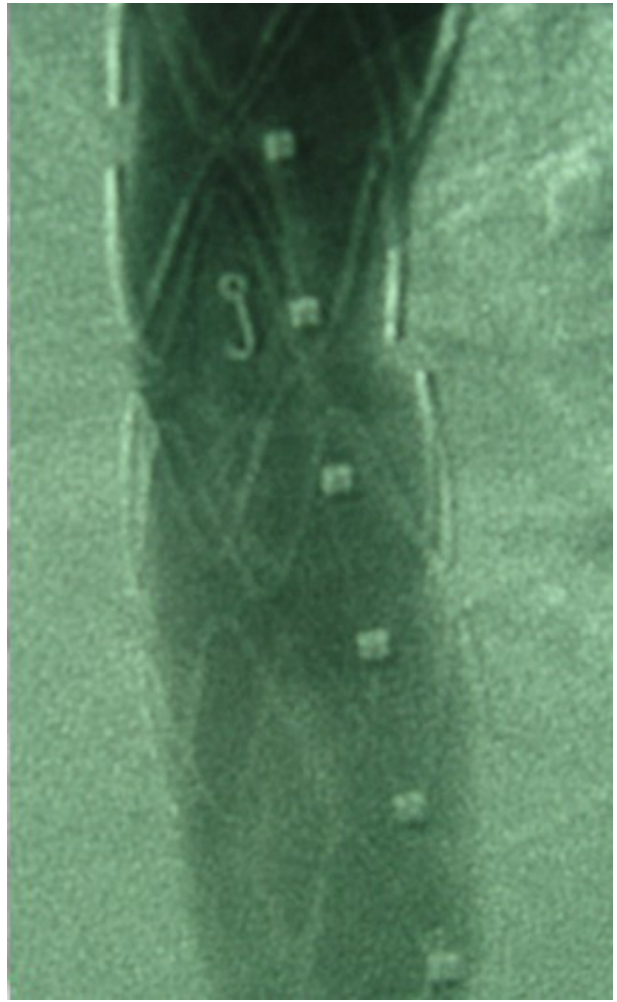
Fig. 5 – Control aortography performed six months after the procedure showing the full expansion of the Dominus® Coarctation Aorta endoprosthesis.